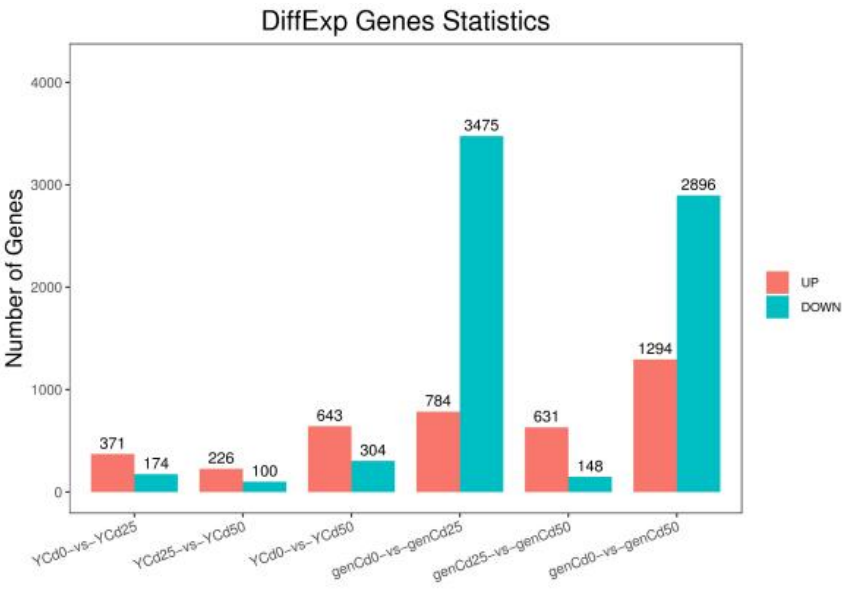
Figure 3. Histogram of differentially expressed genes that were either upregulated (Up) or down-